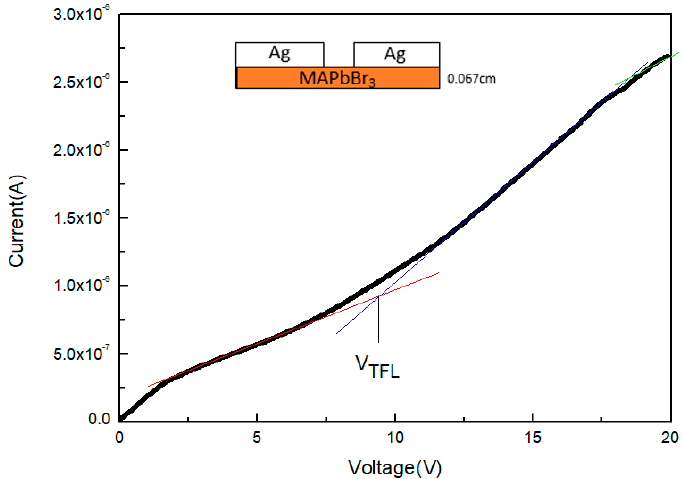
Figure 7. Current–voltage curve of the MAPbBr 3 crystal.